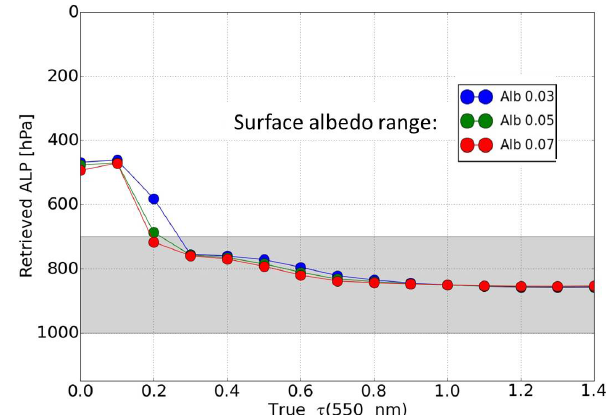
Figure 11. Same as Fig. 10 but with one unique aerosol ω 0 value ( = 0 . 9) and a larger geometric extension of the aerosol layer included in the simulated spectra, i.e. between 700 and